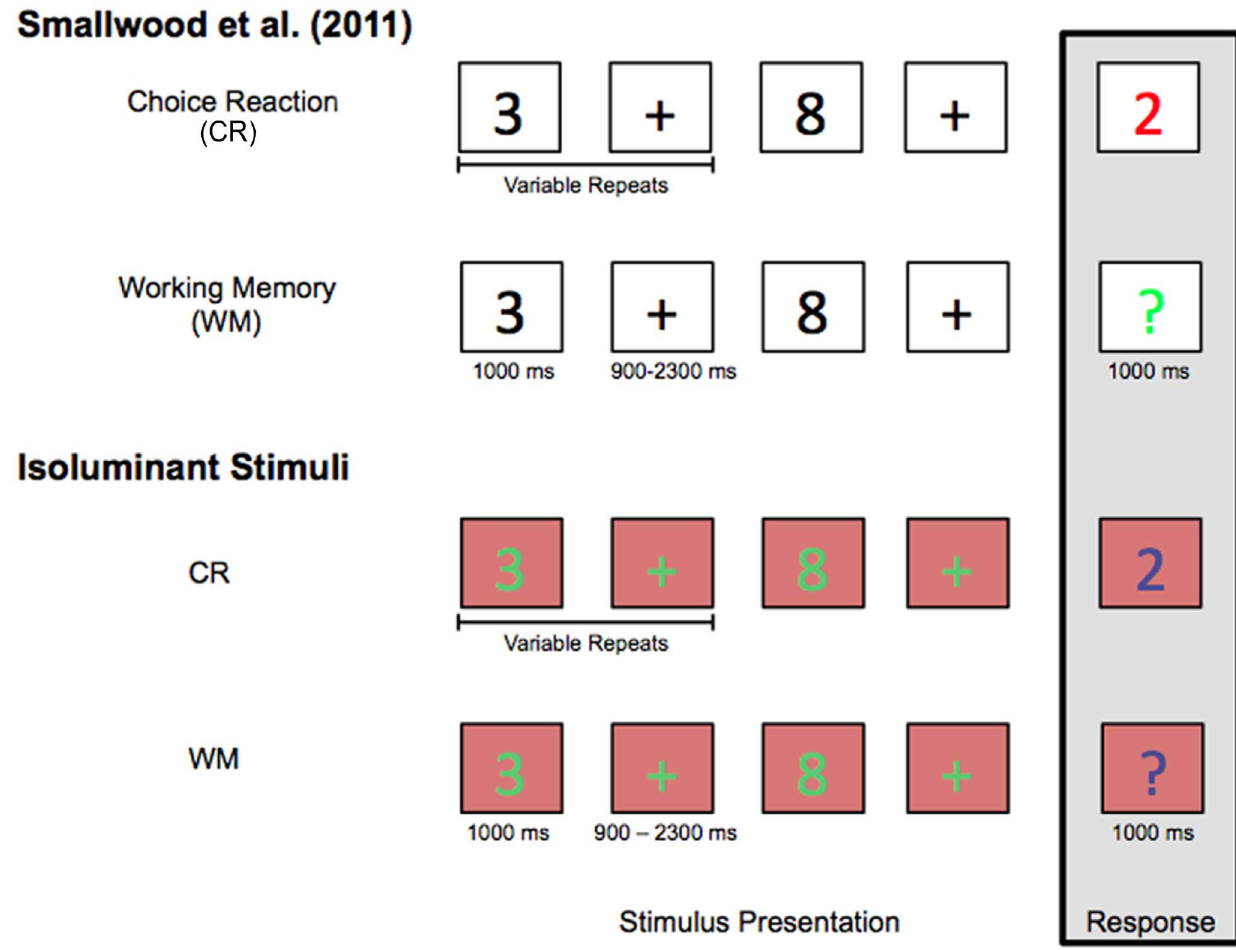
Figure 2. A schematic of experimental tasks used in Smallwood et al. [25] and the current paradigm. The current paradigm conducted an isoluminant replication of the design used in Smallwood et al. [25]. Participants completed both Choice Reaction and Working Memory tasks. In both conditions, they viewed and sporadically assessed the parity of numbers presented on the computer monitor. The Choice Reaction task only demanded attention to colored numbers; the Working Memory condition demanded attention to all presented